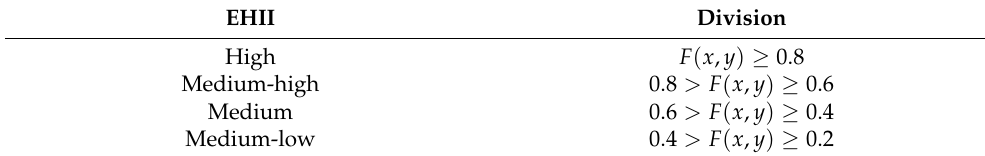
Table 3. The equivalent heat island intensity (EHII) classification method based on the EHI.